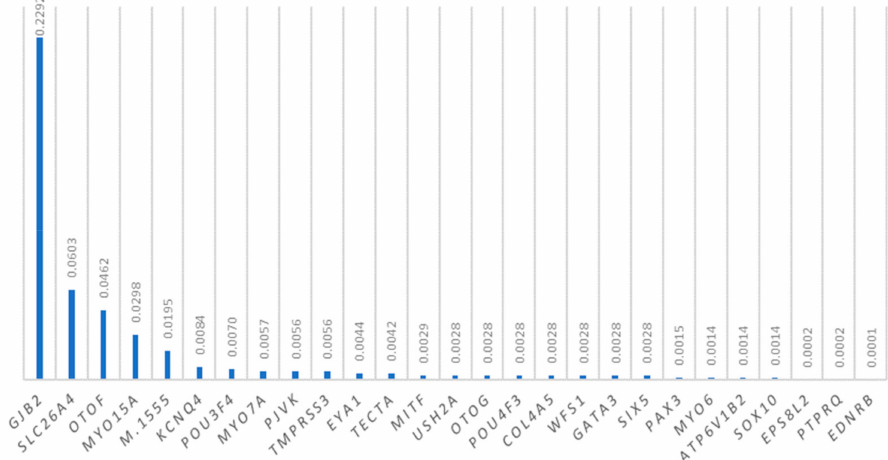
Figure 2. Allele frequencies of deafness-associated genetic mutations in the Taiwanese